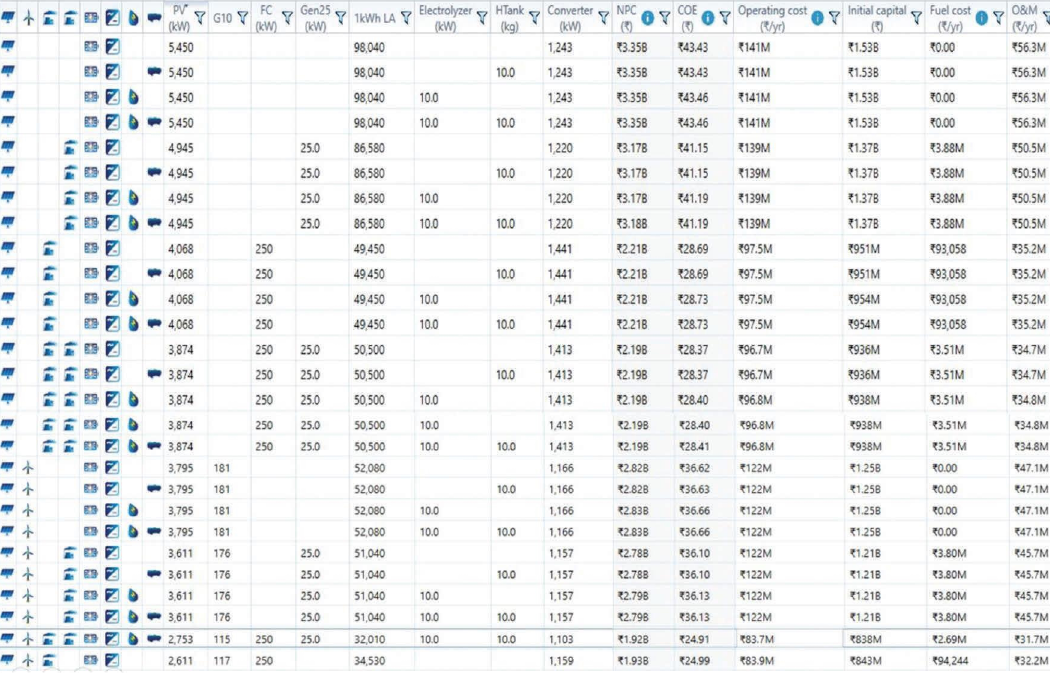
Figure 14: Optimization results using HOMER.